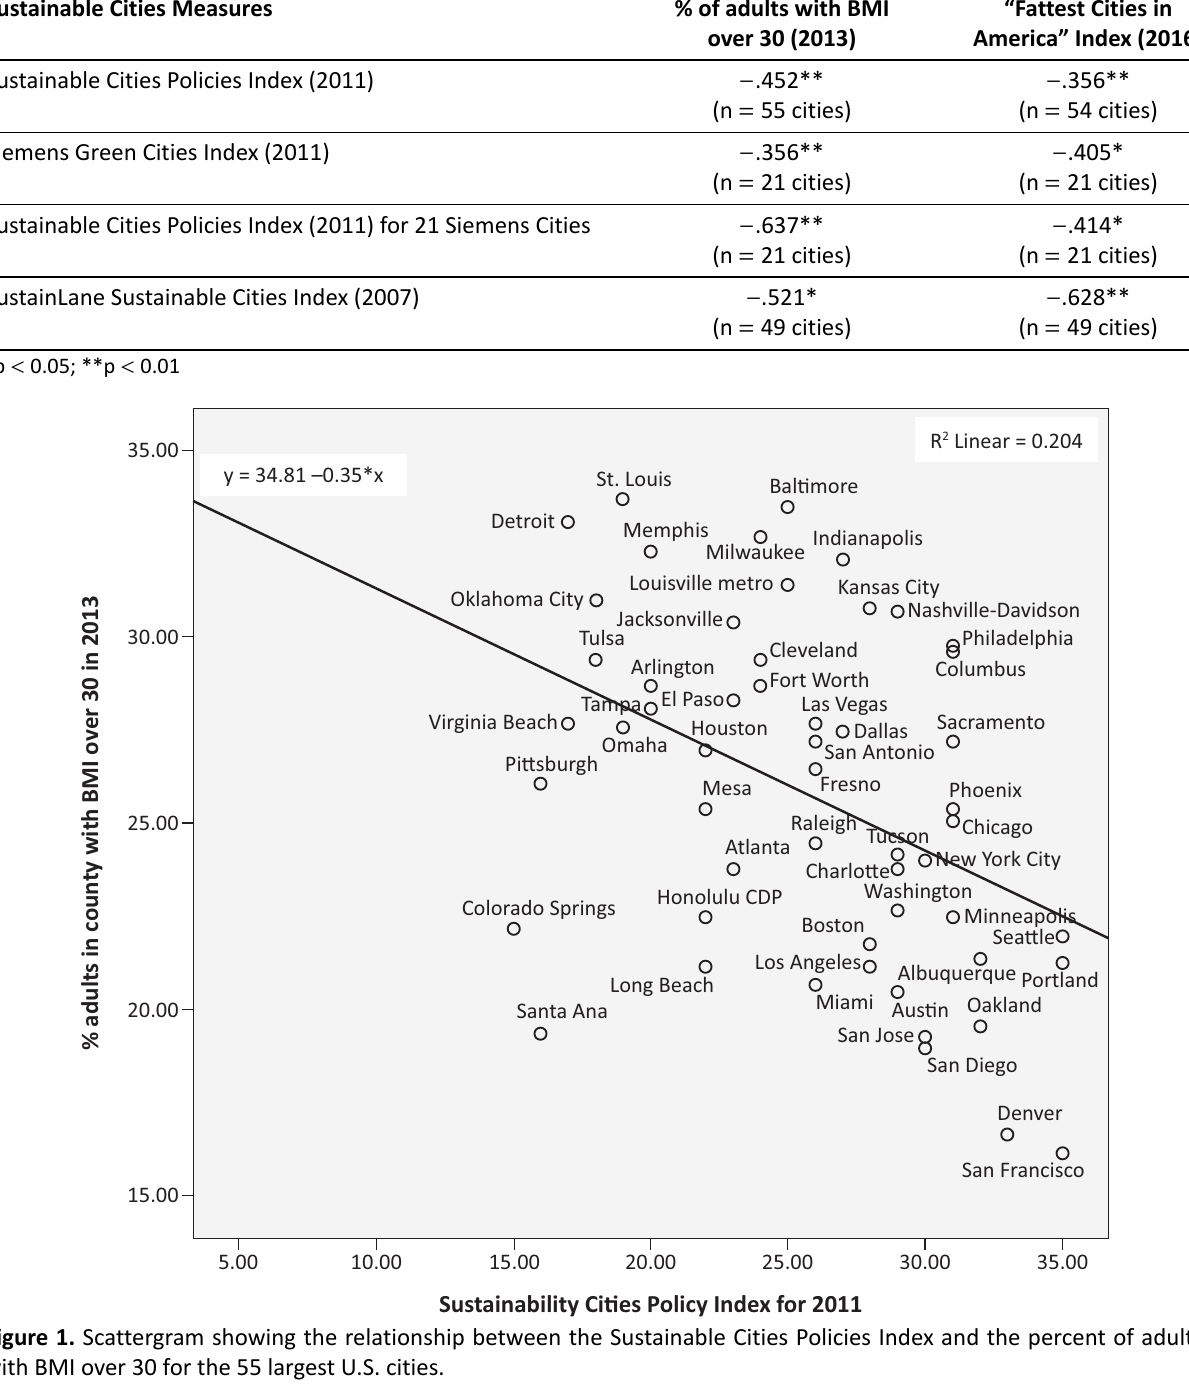
Table 2. Bivariate correlations between Sustainable Cities measures and Health Outcomes measures.